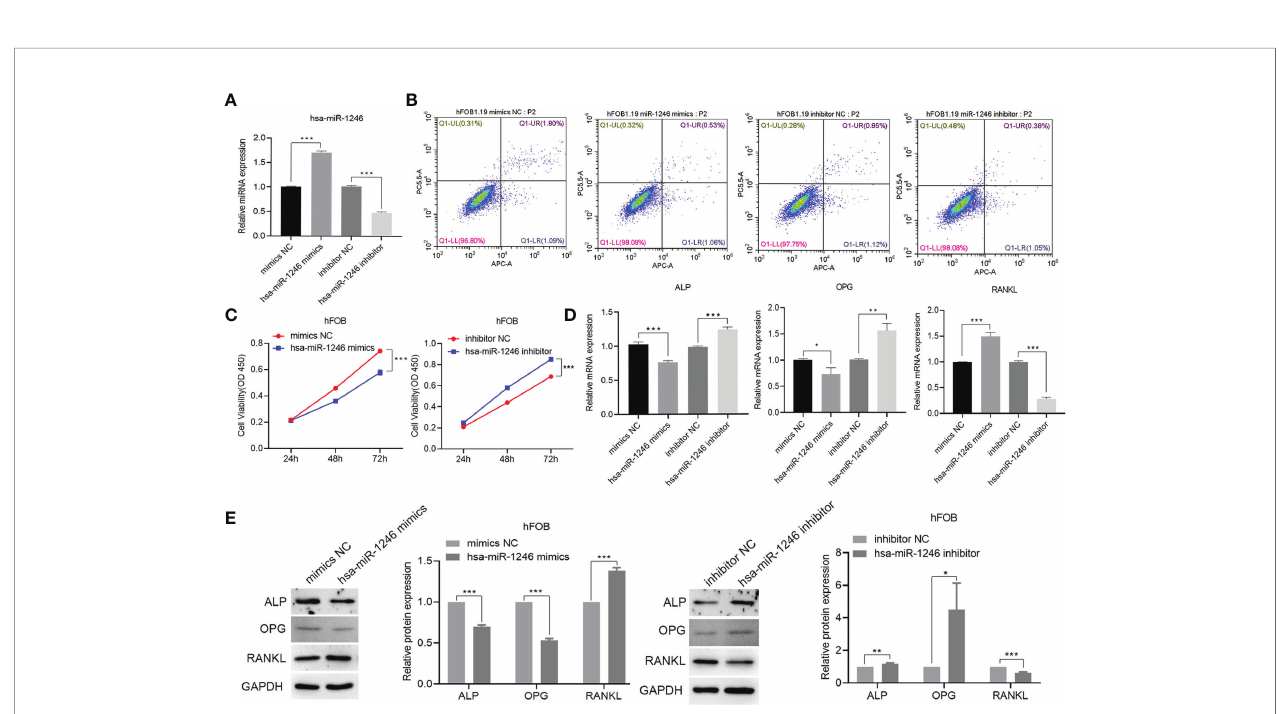
FIGURE 8 | Construction of hsa-miR-1246 mimics and inhibitors. hFOB are cultured and transfected with hFOB-mimics NC, hFOB-inhibitor NC, hFOB-hsa-miR- 1246 mimics, and hFOB-hsa-miR-1246 inhibitor. (A) Veri fi ed overexpression and interfering fragments by qPCR. (B) Cell apoptosis evaluated by fl ow cytometry. (C) Cell viability assessed using CCK-8. (D) QPCR to detect the expression levels of ALP, OPG, and RANKL. (E) Western blot analysis to determine the expression levels of ALP, OPG, and RANKL. (*P < 0.05, **P < 0.01, and ***P < 0.001).